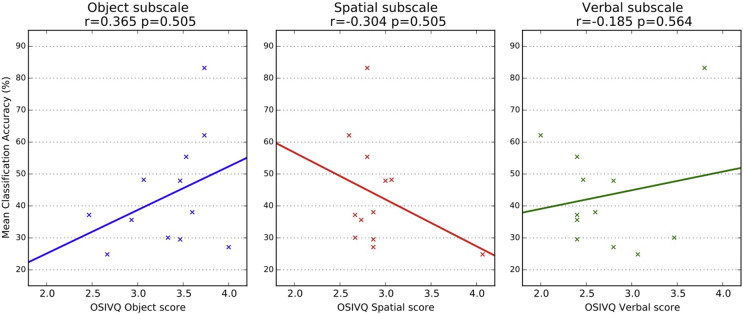
Scatter plots for Object-Spatial Imagery and Verbal Questionnaire (OSIVQ) scores and average classification accuracies (across all ROIs). Scores from the three OSIVQ scales “object” (blue), “spatial” (red), and “verbal” (green) are plotted against the average classification accuracies for each subject. The colored lines show linear regressions for each OSIVQ scale. Correlations and corresponding p-values are shown in titles of each subplot.